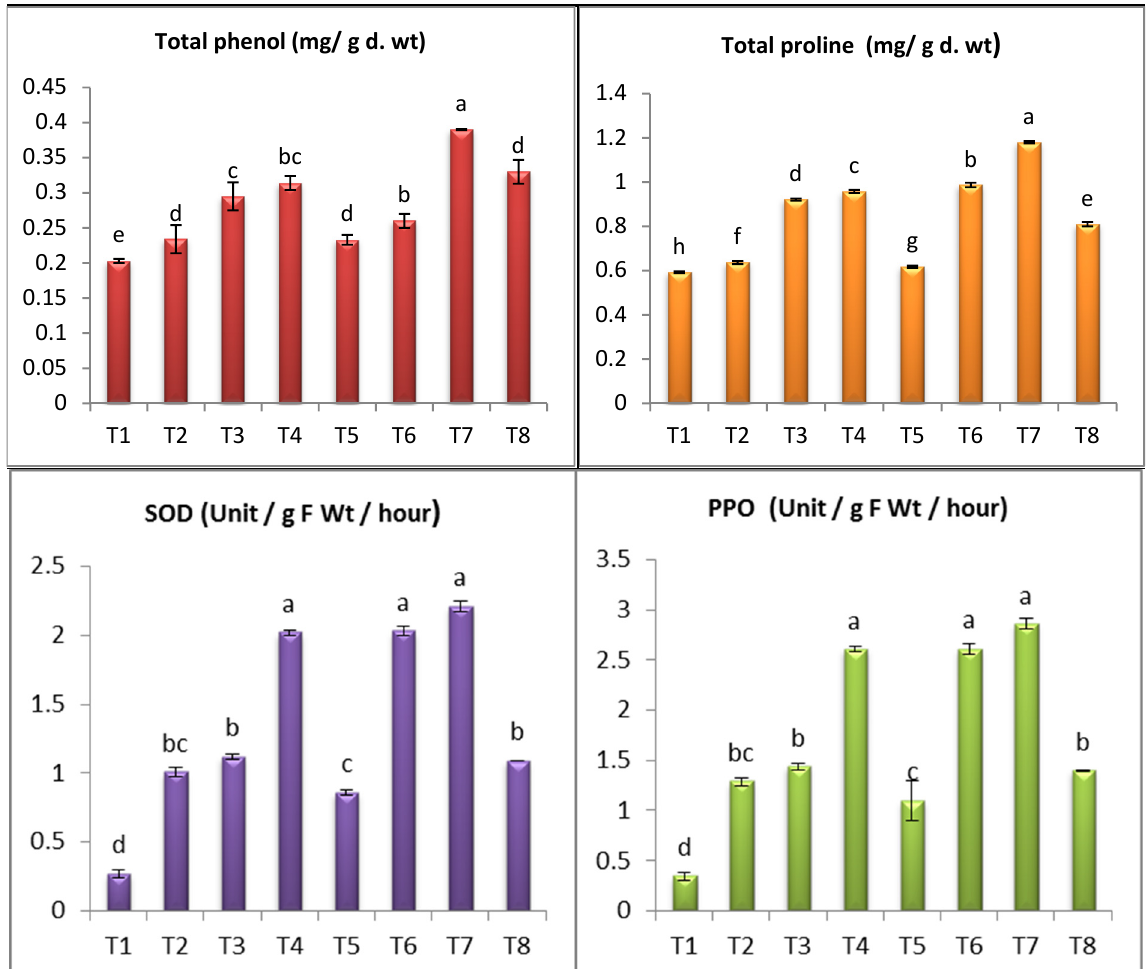
Figure 8. Effect of SiO 2 -NPs and SiO 2 on oxidative stress markers of S. melongena . (a–h revealed to significance letters).